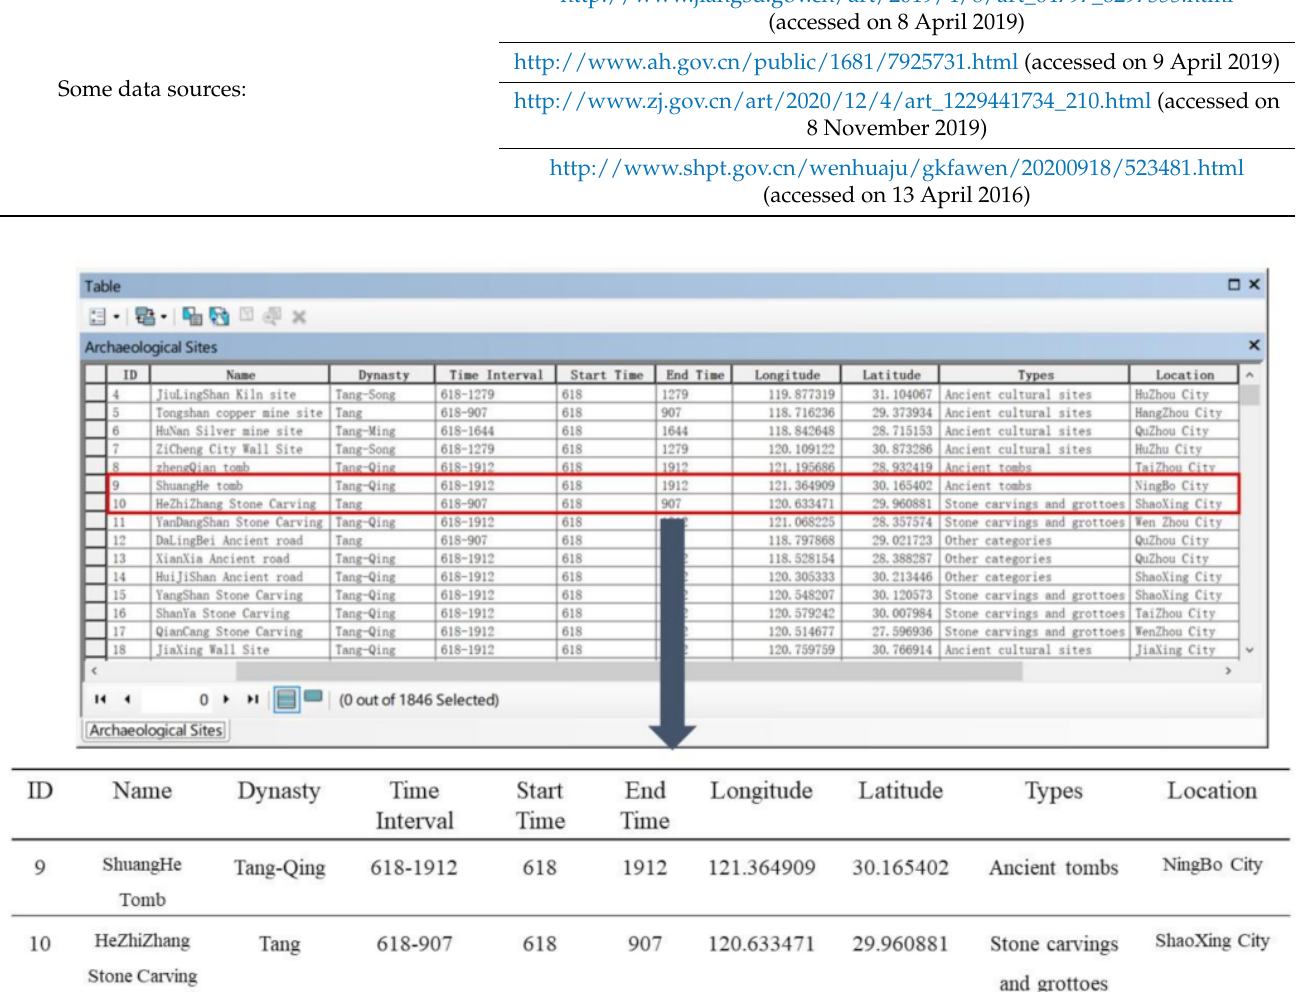
Figure 1. Attribute table of Archaeological Sites’